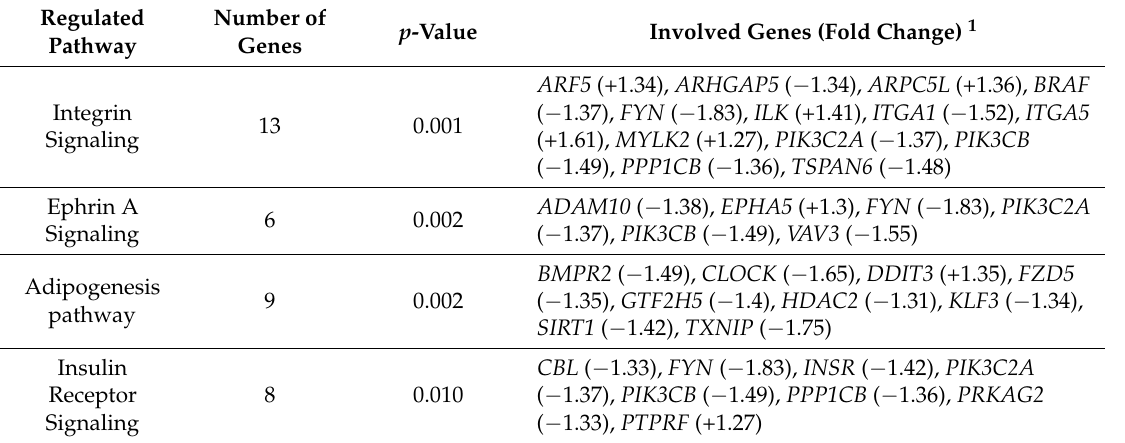
Table 3. Pathways altered between feed efficiency (FE; measured by residual feed intake)-divergent animals in liver tissue at a significance level of p < 0.01.